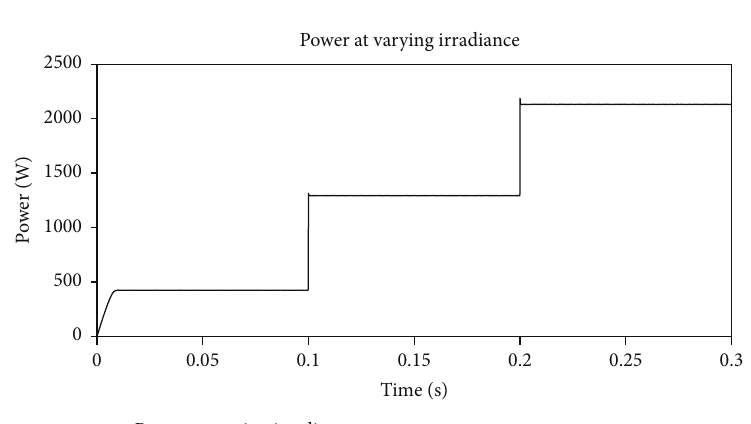
Figure 4: Tracking of PV module voltage.